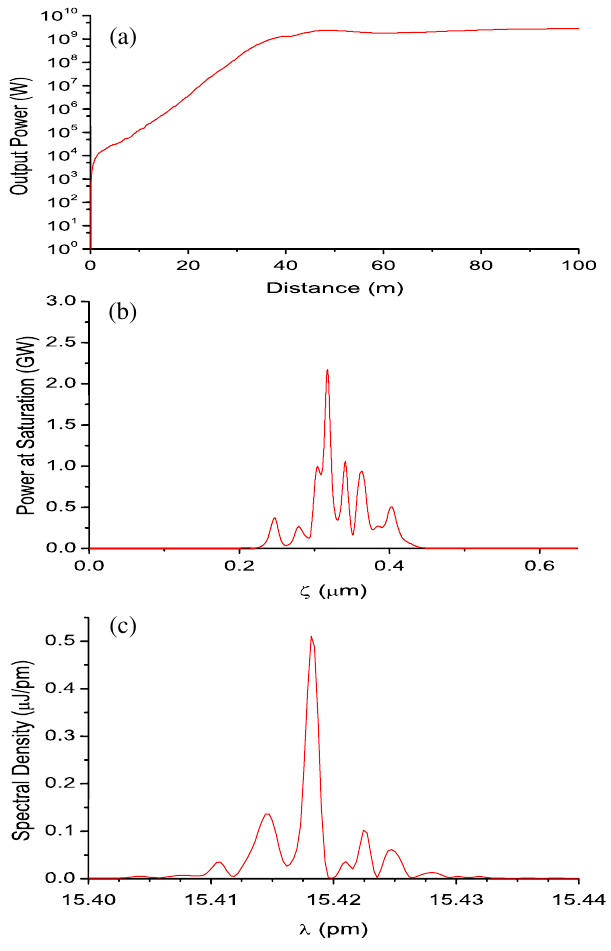
FIG. 8. (Color) (a) GENESIS simulation of a 13.65 GeV LCLS beam traveling through the cryogenic high field